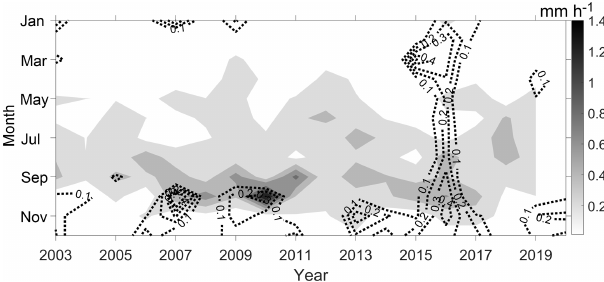
Figure 11. Time series of the rainfall rate (contours) and Chl a con- centration (dotted curves with text labels). The values on the con- tours are the exponents of the Chl a concentration.